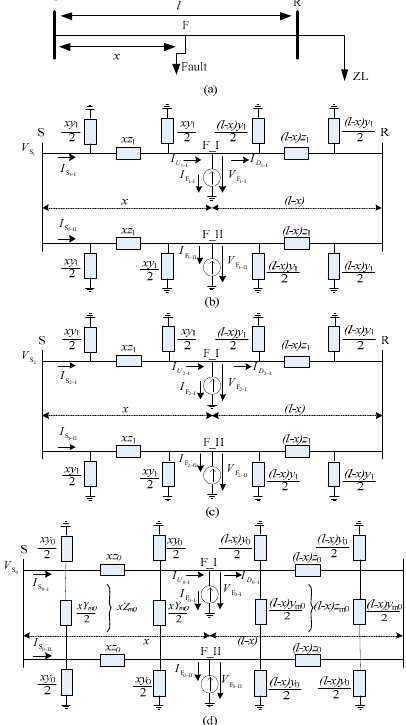
Figure 1. ( a ) Single-line diagram for each section of a power distribution system; ( b ) Positive; ( c ) negative; and ( d ) zero-sequence networks of a double-circuit distribution line during a usual